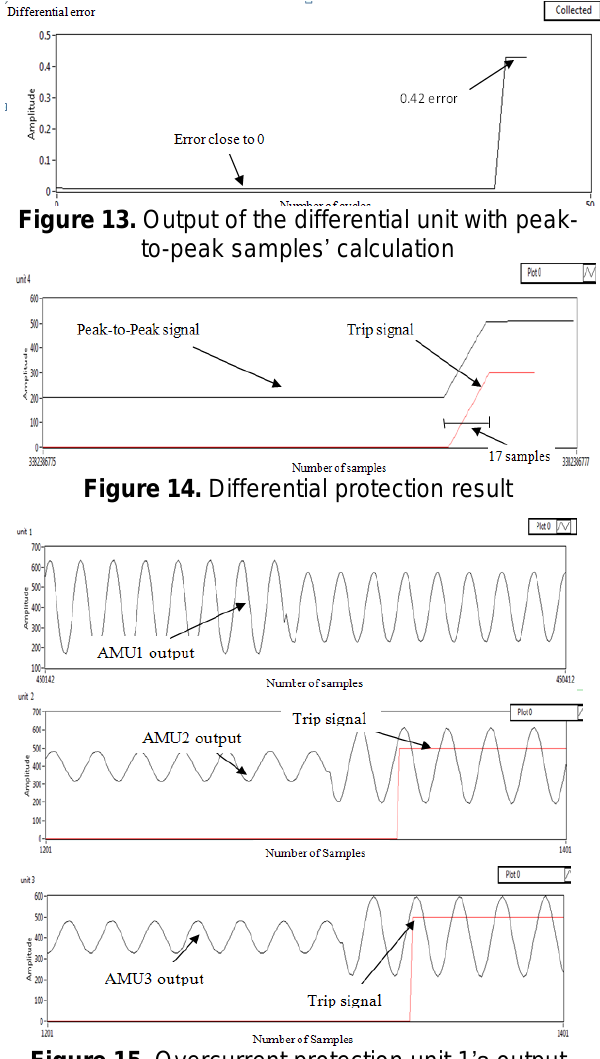
Figure 15. Overcurrent protection unit 1 ’s output during a